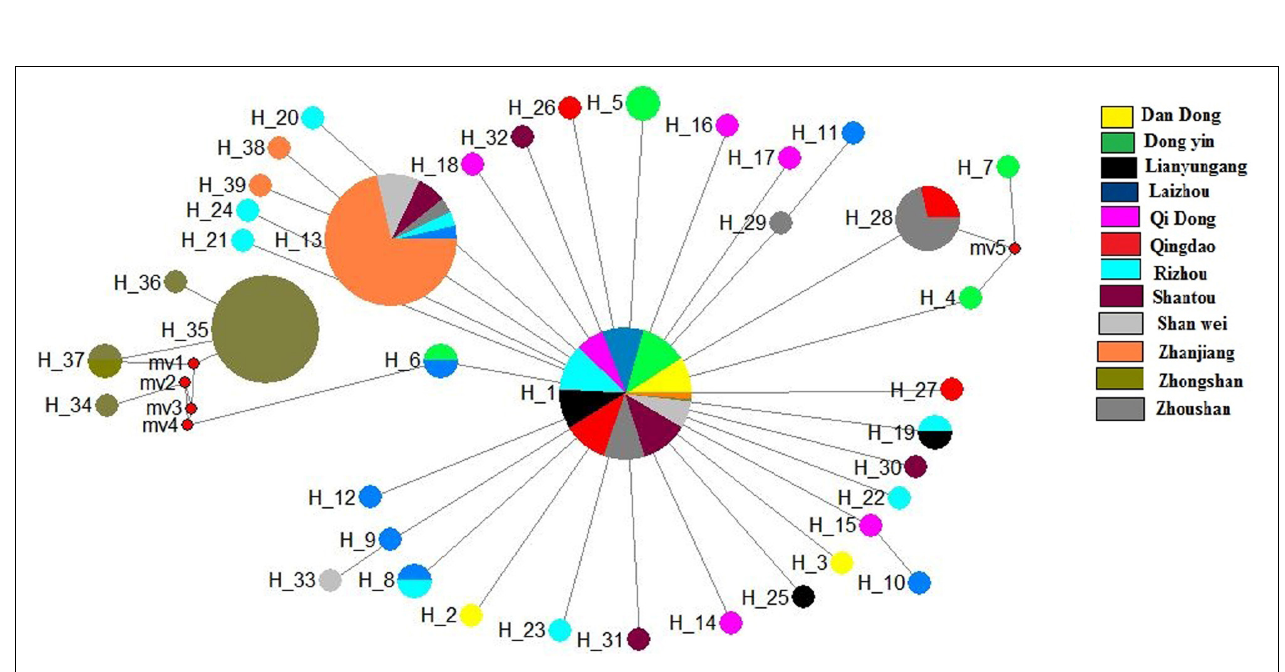
FIGURE 5 | Median-joining networks of Konosirus punctatus developed using Cytb data. Color representation is showing the population frequency. Shown numbers are representing the haplotype numbers.